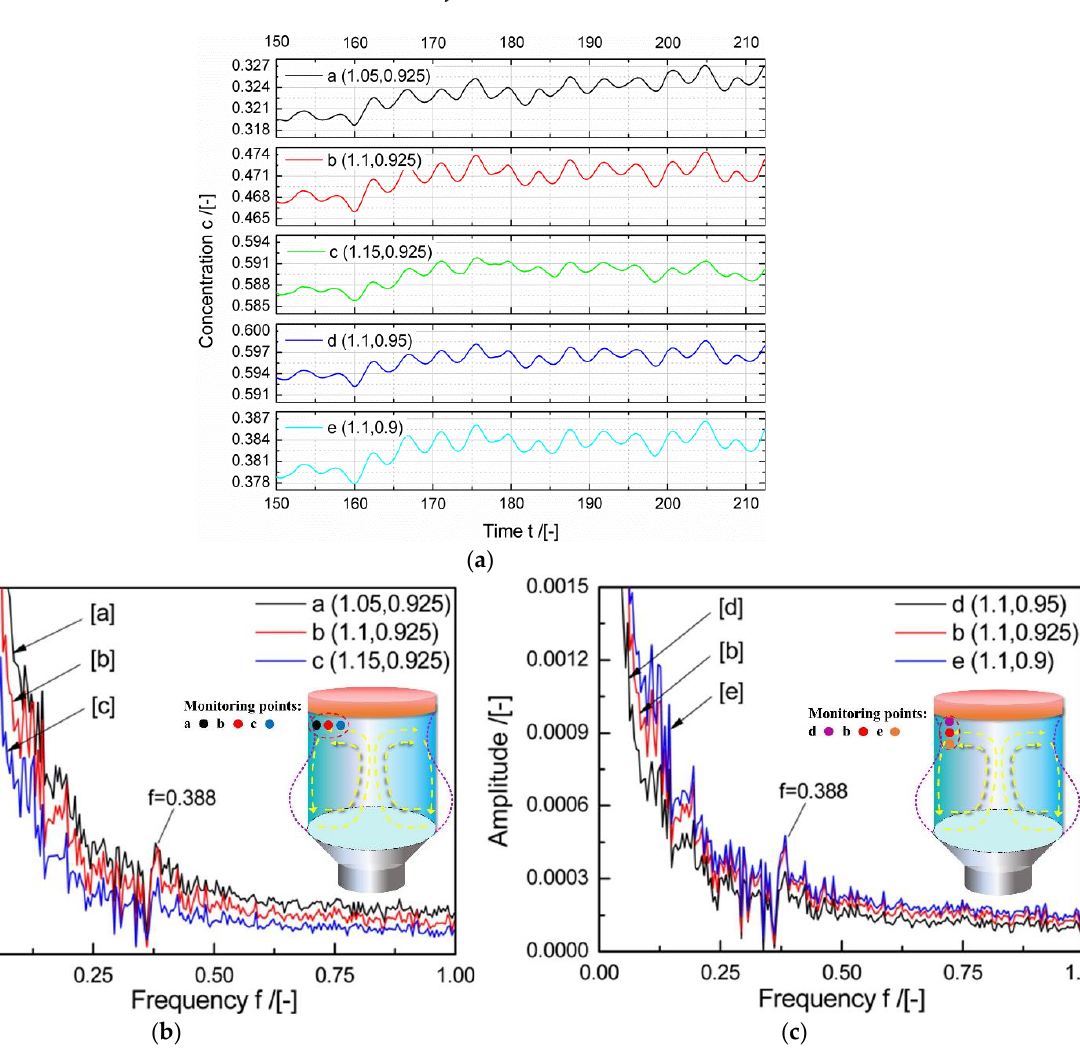
Figure 4. ( a ) Concentration variation of monitoring points in upper corner area; ( b , c ) FFT spectra of concentration oscillation in horizontal and vertical directions ( Ca C = −0 .01, R = 2.5mm, H/R = 1.0, Vr = 1.0).